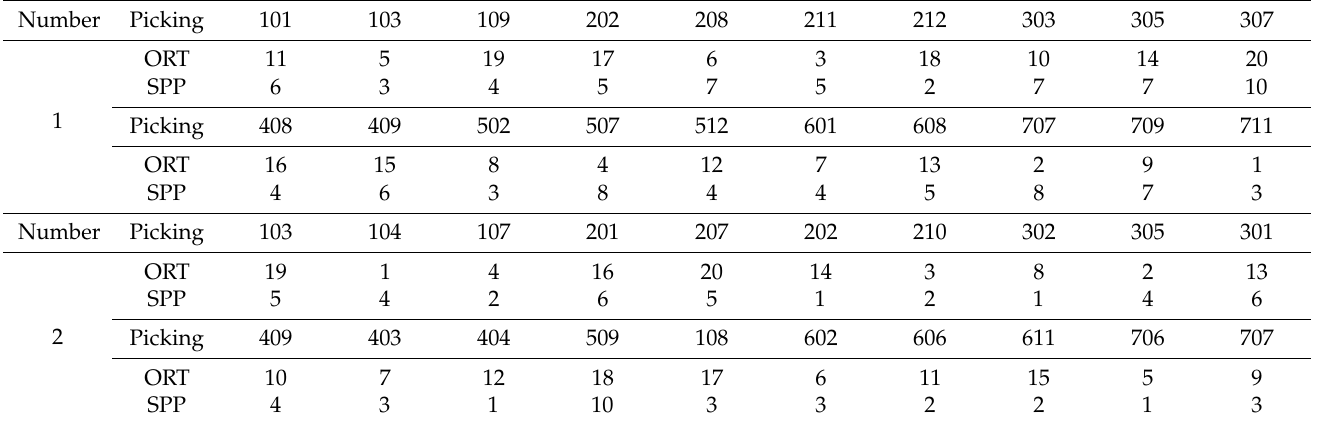
Table 5. Shortage and order of test samples.